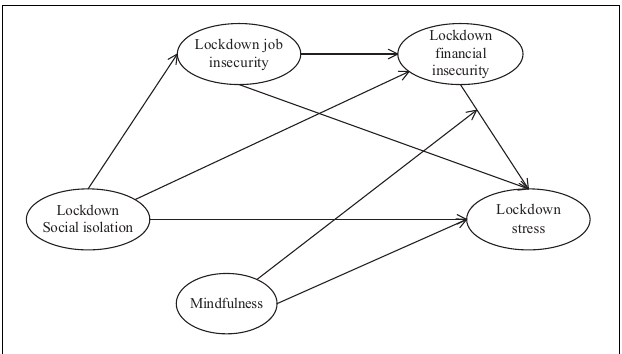
FIGURE 1 | Hypothesized